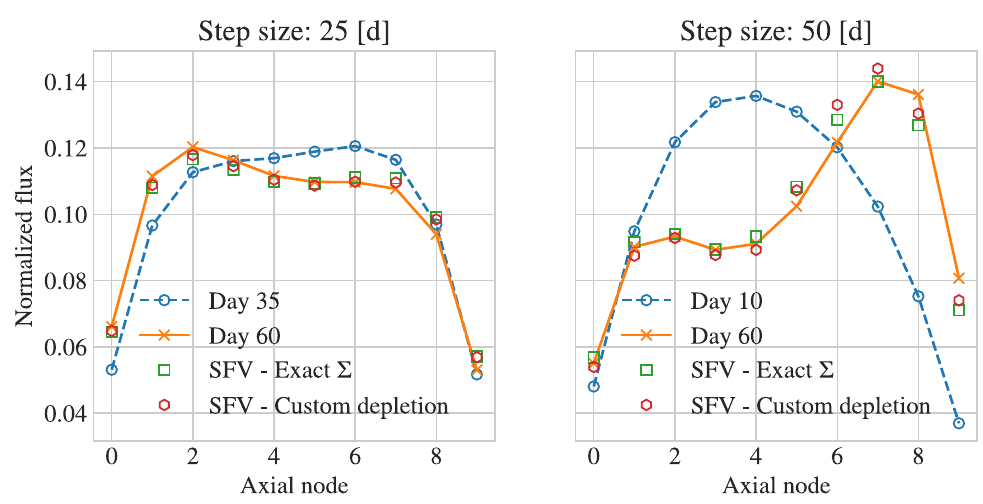
Figure 4: BOS and EOS Serpent fluxes for 25 and 50 day steps with SFV predicted